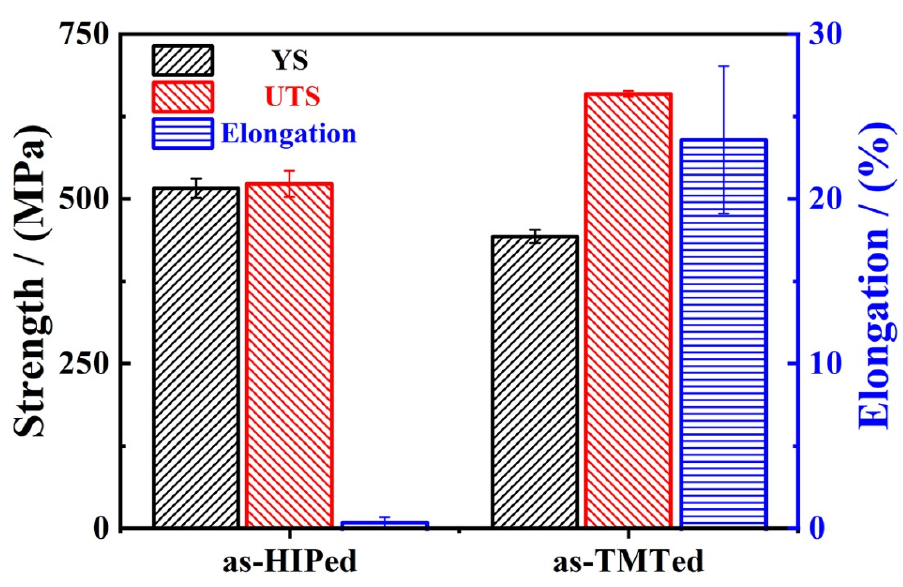
Figure 7. The ultimate tensile strength (UTS), yield strength (YS) and percentage elongation after rupture (A) for the as-HIPed and as-TMTed samples tested at 25 °C.